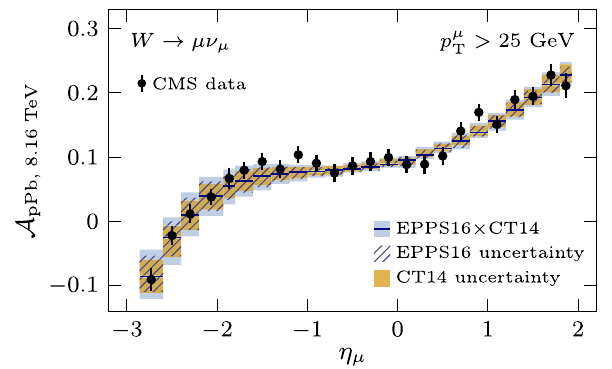
Fig. 11 The W ± production charge asymmetry, with a breakdown of theory uncertainties as in Fig.